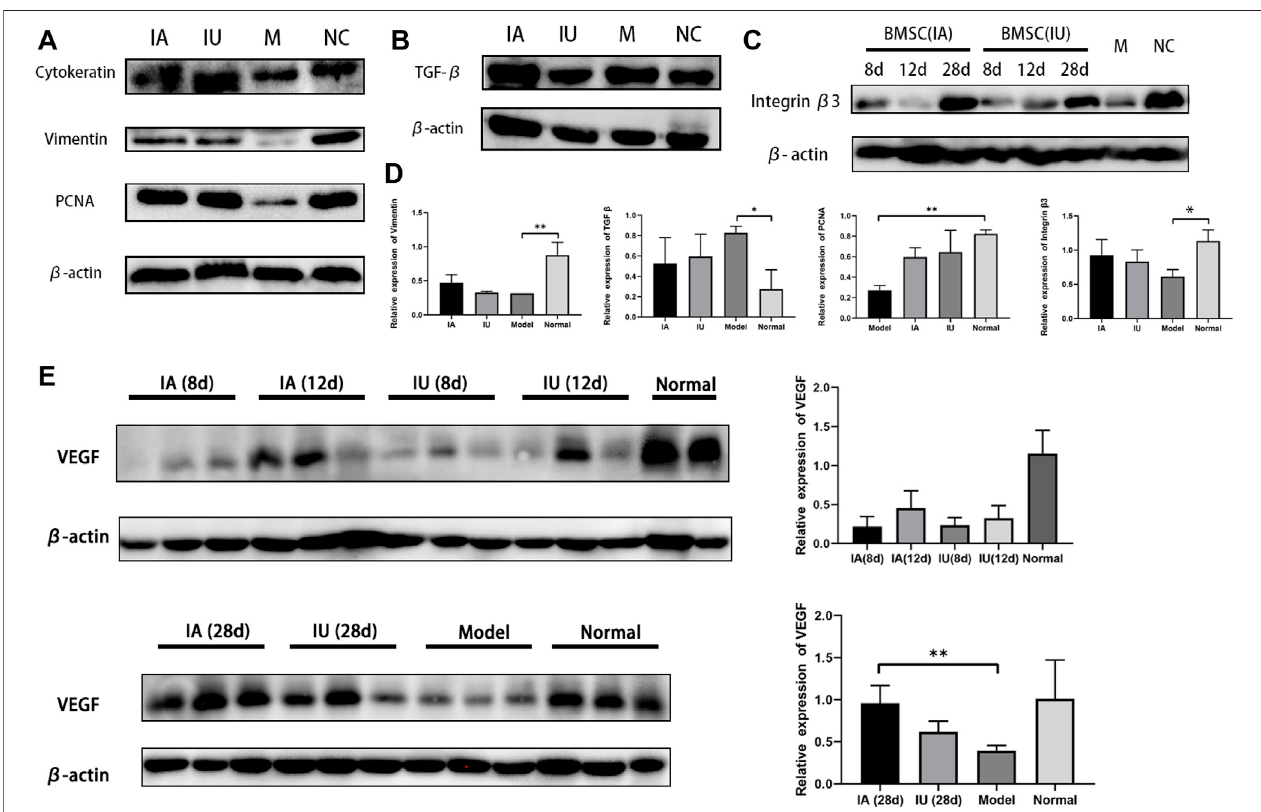
FIGURE 6 | Representative Western blot results of cytokeratin, vimentin, PCNA, TGF- β 1, and VEGF. (A,B) Cytokeratin, vimentin, PCNA and TGF- β 1 showed a comparable increase in the two BMSC-infused groups (group IA and IU) (C) Differential expression of integrin β 3 in four groups at the same time point. (D) The semi- quanti fi cation analysis of the expression of Vimentin, TGF- β 1, PCNA, Integrin β 3 in four groups, achieve by Image J software. (E) Expression of VEGF in four groups at differenttimepointspostmodeling. Theexpression levelsanalyzed byImageJquanti fi cationareshownontheright. (NC,normal; M,model;IU,BMSCIU-injection; IA, BMSC